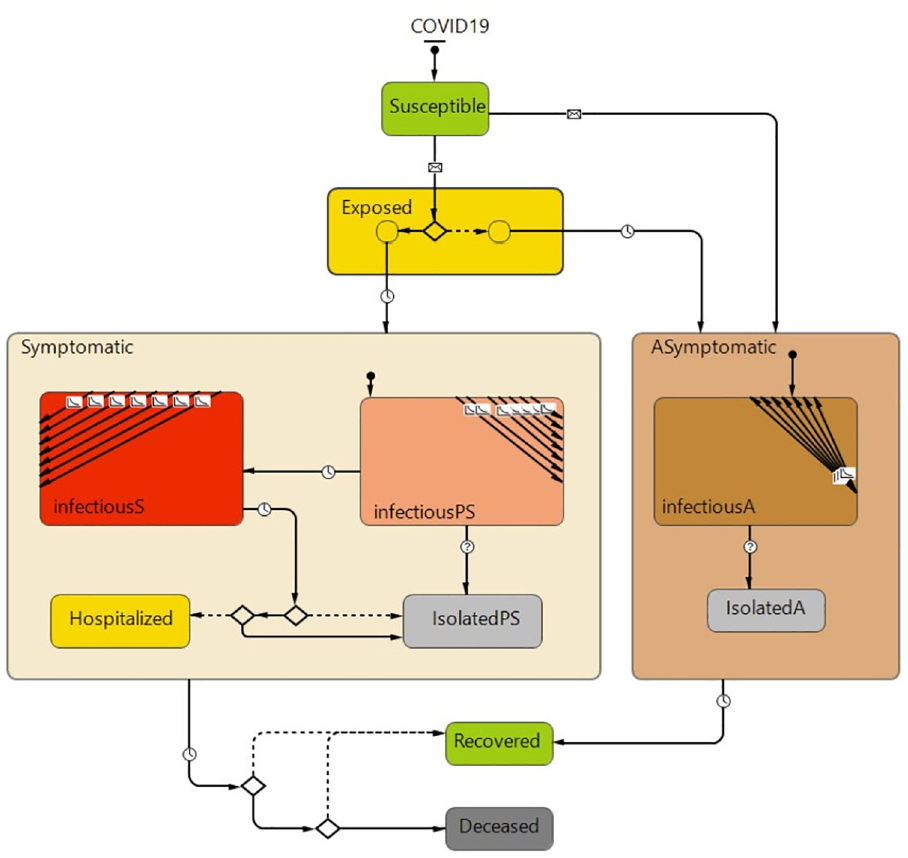
Fig 5. Disease transmission model of the dialysis